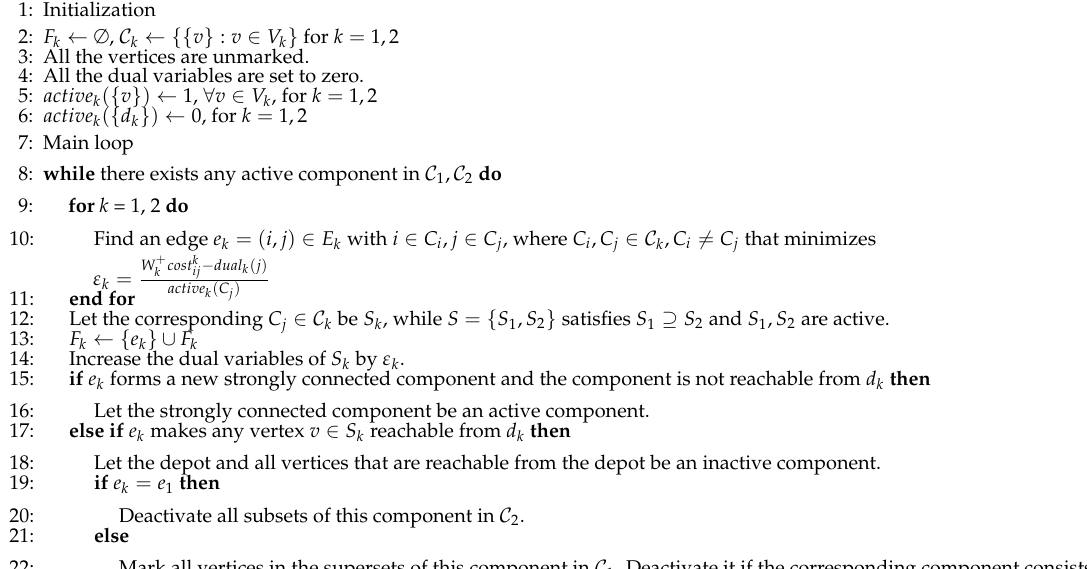
Algorithm 3 Primal-dual heuristic for finding an